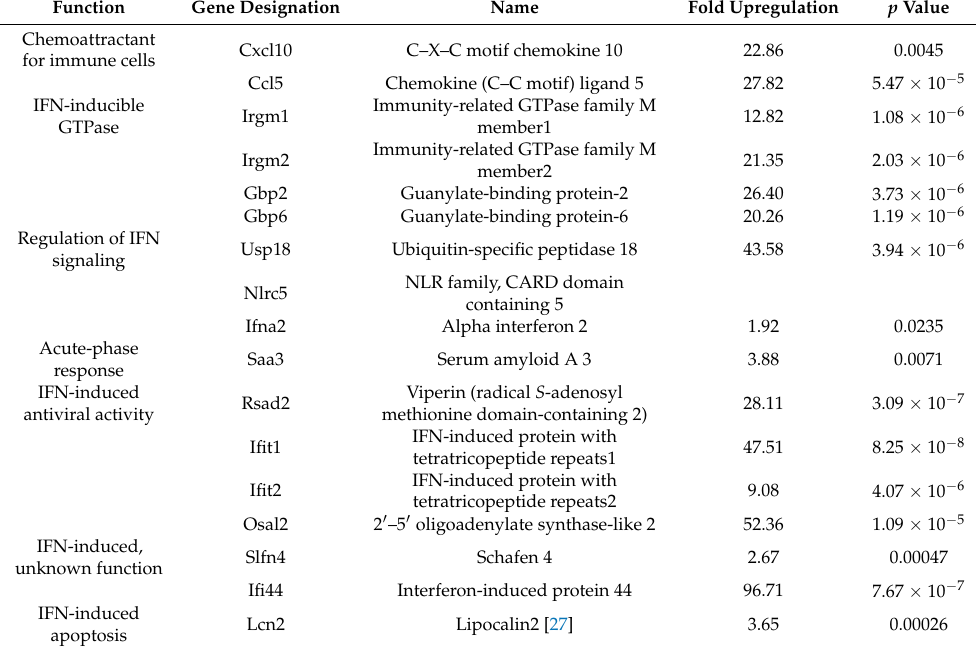
3856 5853 Microarray analysis was performed on RNA extracted from the mouse cerebellar and spinal cord slices infected with WNV. The data ( n = 3 per group) were analyzed using Student’s t -test with Bonferroni’s correction. p < 0.05 was considered statistically significant. Table 3. Genes associated with IFN signaling are highly upregulated in the mouse CSCs infected with WNV. The data ( n = 3) were analyzed using Student’s t -test with Bonferroni’s correction ( p < 0.05 statistically significant).